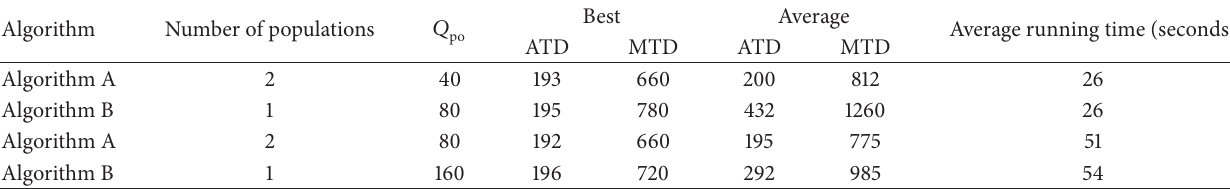
Table 3: Comparison of solution with different algorithms.